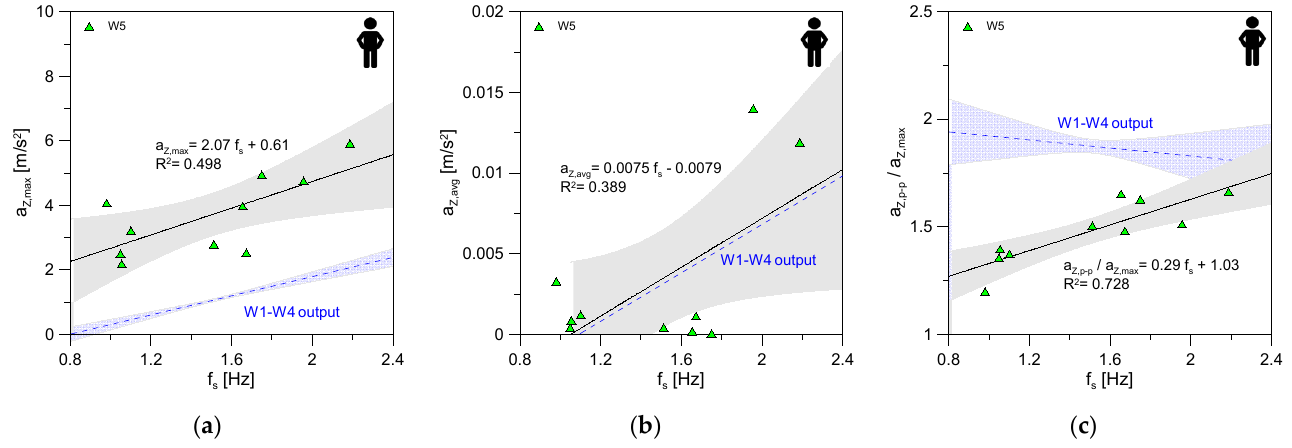
Figure 15. Summary of experimental records for W5 configurations (10 in total, SLAB#1), as a function of calculated walking frequency: ( a ) peak of vertical acceleration, ( b ) average vertical acceleration, ( c ) peak-to-peak versus maximum acceleration. The 95% confidence interval is shown in grey colour. Table 4. Analysis of W5 vertical acceleration data (SLAB#1, 10 samples), with standard deviation in brackets and correlation coefficient R .